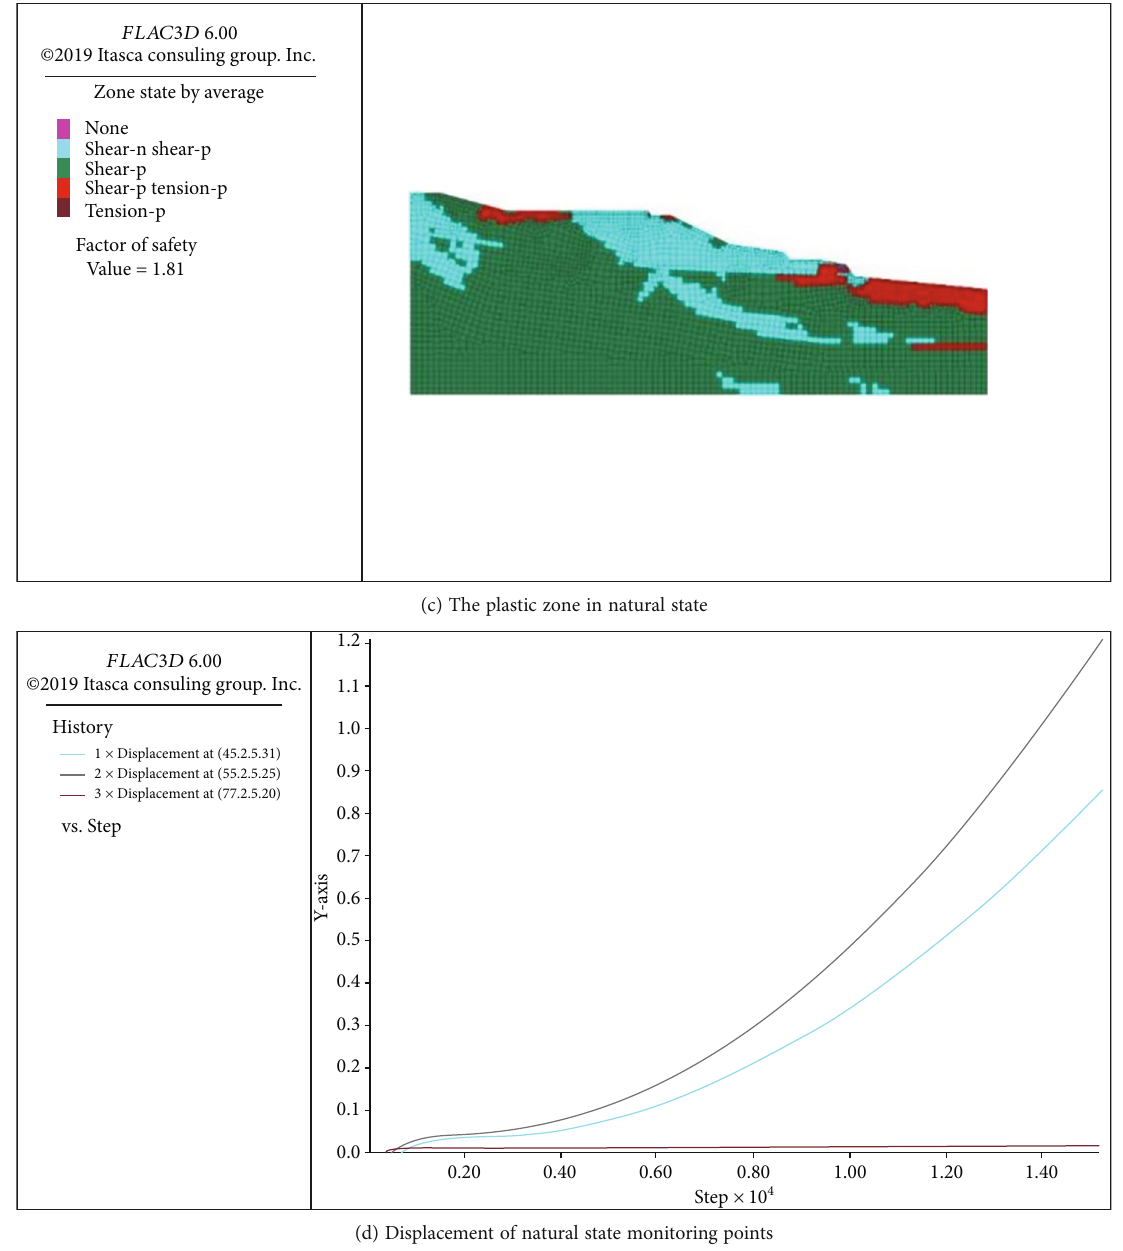
Figure 15: The stability of slope in natural